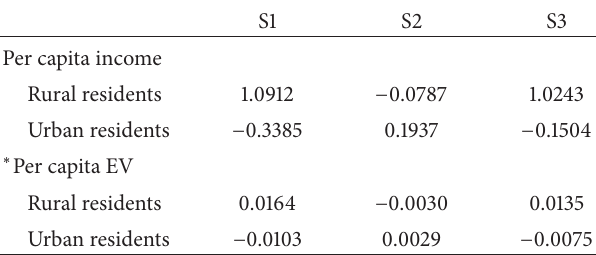
Table 3: Urban and rural residents per capita income and welfare (EV) in 2015 (% change).